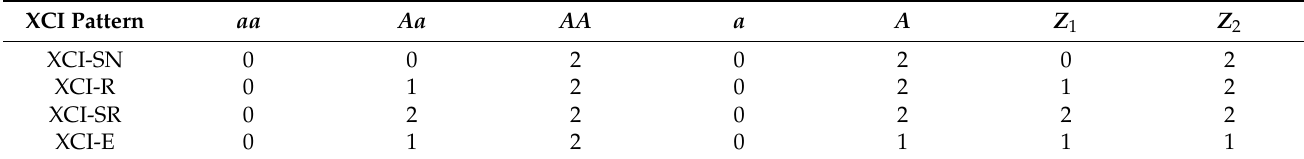
Table 1 lists the genotypic scores for all five genotypes and the corresponding values of Z 1 and Z 2 under the four special XCI patterns. Table 1. The genotypic scores for five genotypes and their corresponding values of Z 1 and Z 2 under the four special XCI